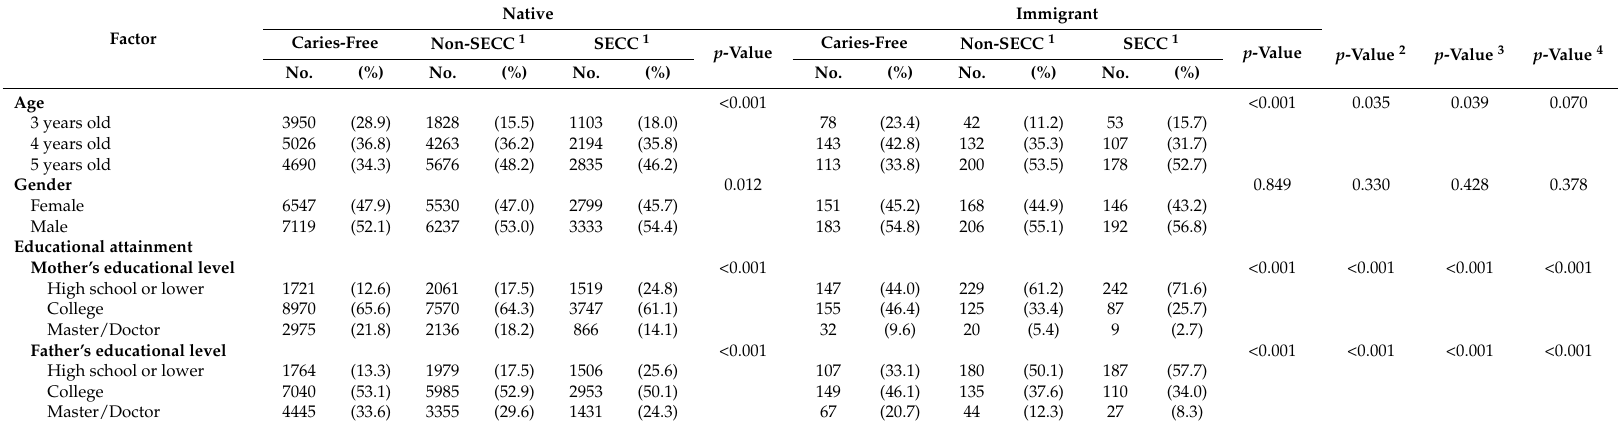
Table 2. Demographic backgrounds of children aged 3–5 years in relation to dental caries status in native and immigrant